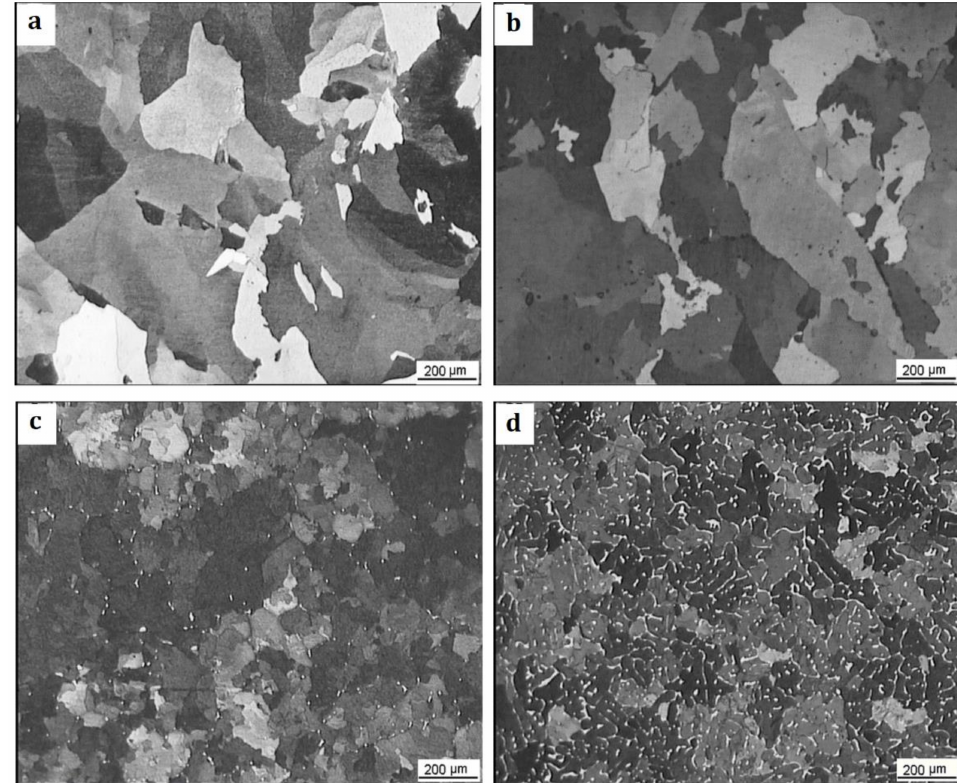
Figure 1. Optical micrographs of Cu-bearing steel 1 ( a ), steel 2 ( b ), steel 3 ( c ), and steel 4 ( d ). The etchant was 4% nital.